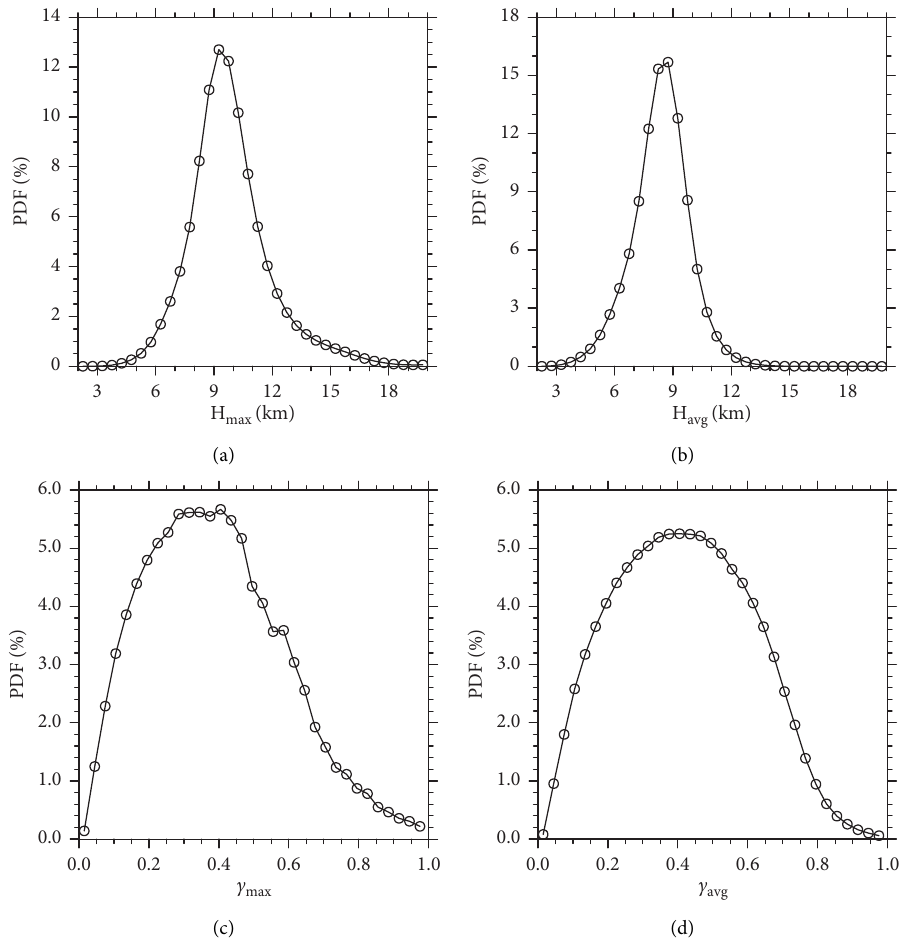
Figure 4: The PDFs of vertical geometrical parameters for H to